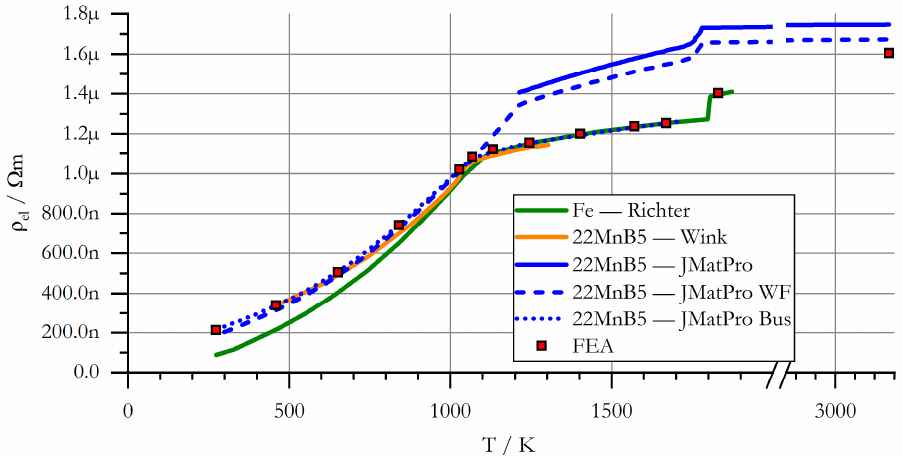
Figure 9. Specific electric resistance of 22MnB5, computed data.